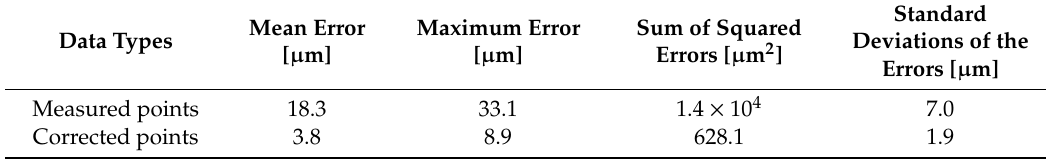
Figure 12. Contour of the Euclidean residuals between each certified and measured points.